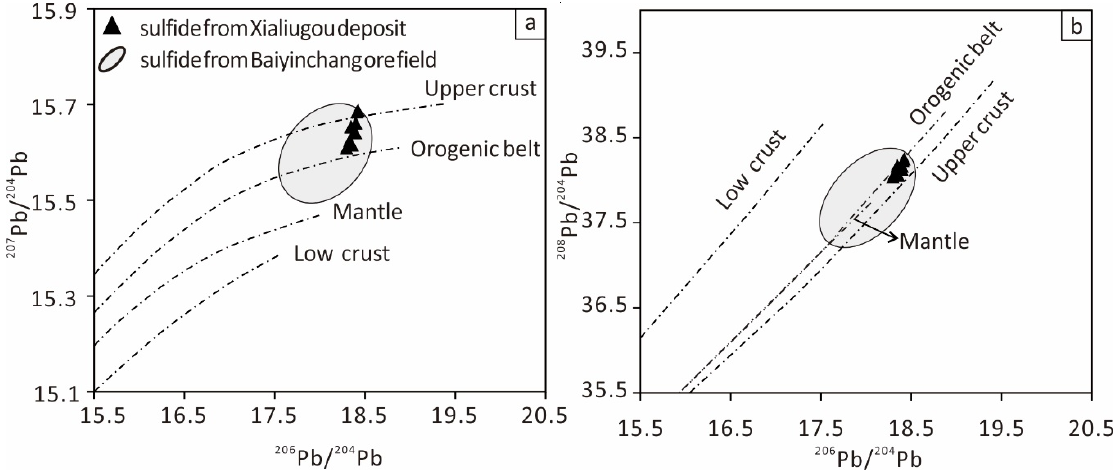
Figure 10. The 207 Pb/ 204 Pb– 206 Pb/ 204 Pb ( a ) and 208 Pb/ 204 Pb– 206 Pb/ 204 Pb ( b ) diagrams of the Pb isotopic compositions for sulfide minerals (pyrite) from the Xialiugou deposit, modified from reference [42]. Data for Baiyinchang ore field cited from [51,55].